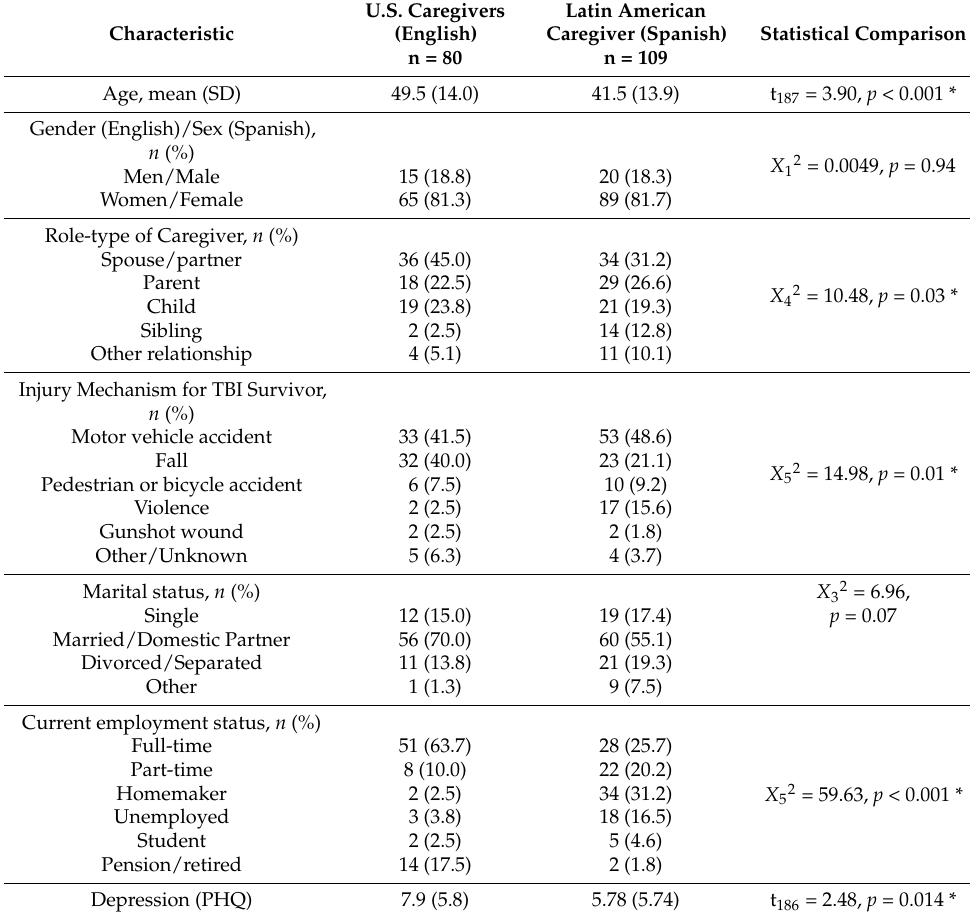
Table 1. Participant